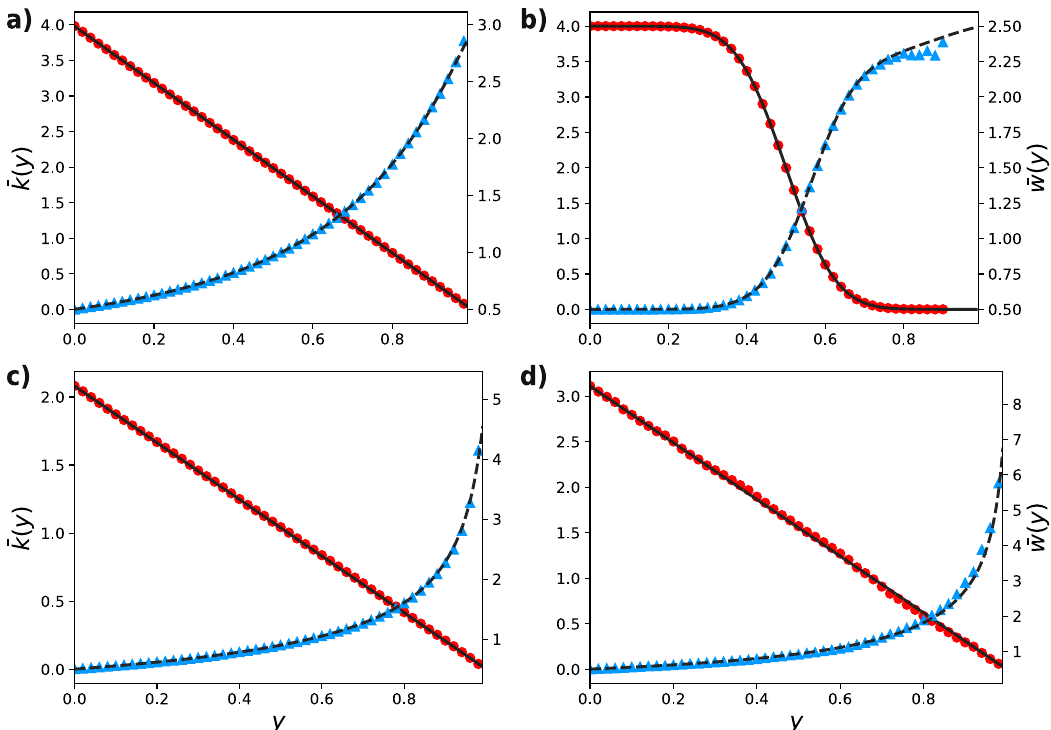
Fig. 4 Average degree and average weight for single instances of the damage – response process. Colored markers represent the outcome of a single stochastic simulation. Solid and dashed lines represent the analytical results for average weight and degree (derived in the Methods section). Red dots and continuous lines represent the average degree (left scale), while blue triangles and dashed lines represent the average weight (right scale). a Poisson network of N = 25 × 10 3 nodes and uniform weights. b Random regular graph with N = 25 × 10 3 nodes and normally distributed weights (same distribution of Fig. 2). c Scale-free network of N = 25 × 10 3 nodes with power-law exponent γ = 2.5 and uniform weights. d Empirical network with uniform distributed weights (same network as in Fig.